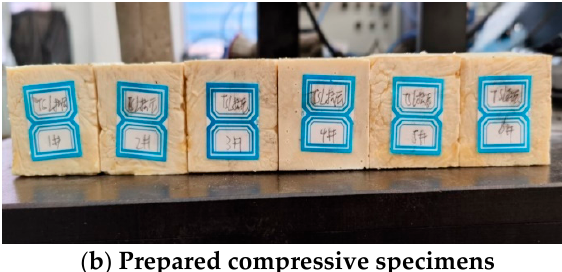
Figure 2. Compression mould and sample.